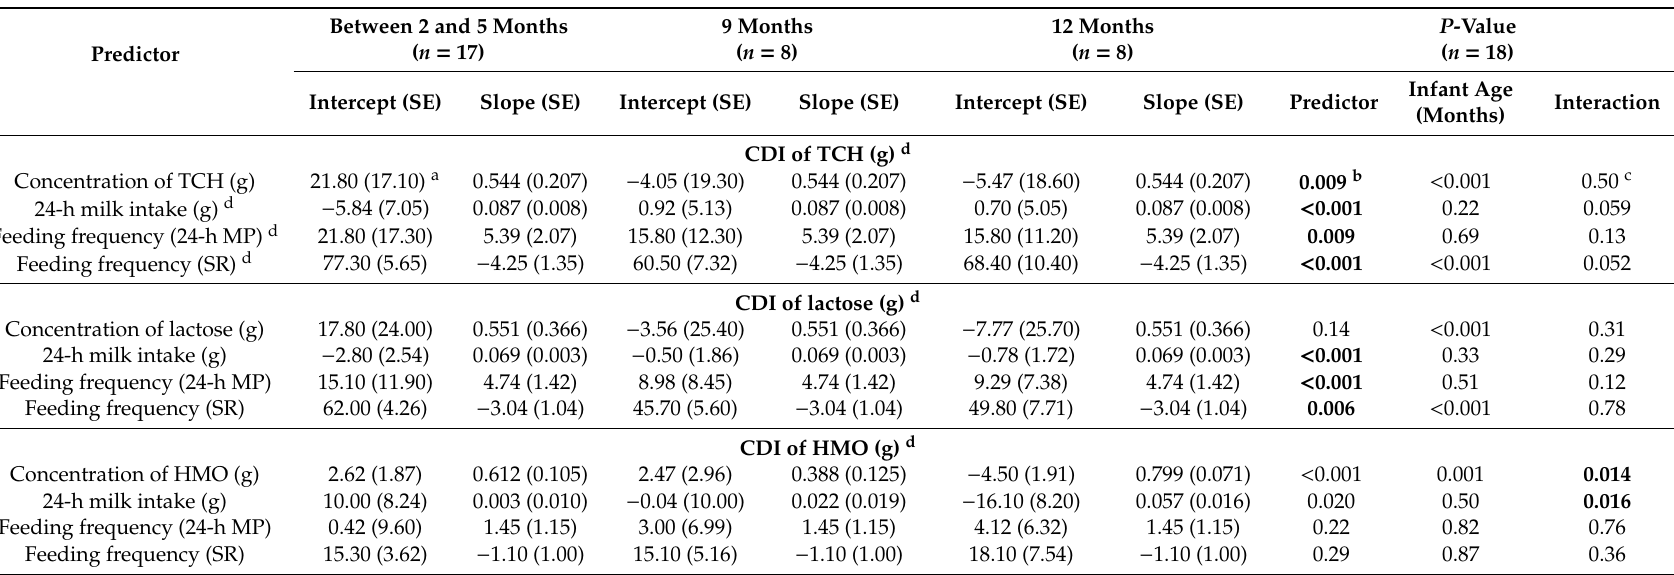
Table A2. Associations of daily intakes of human milk carbohydrates with concentrations and breastfeeding parameters.